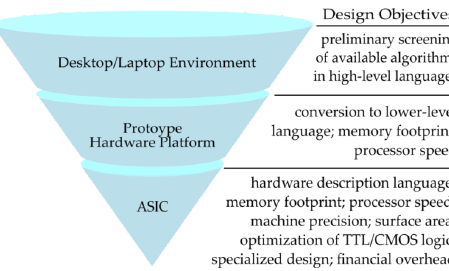
Figure 3. Methodological framework towards an Application-Specific Integrated Circuit (ASIC) implementation.